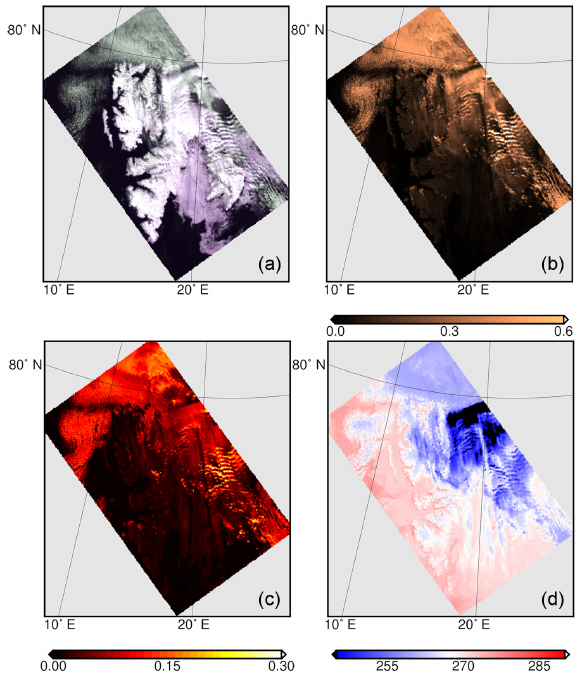
Figure 1. (a) The false-colour RGB image of AATSR (using 0.67, 0.87 and 0.55µm channels) over Svalbard, 10 May 2006, (b) 1.6µm reflectance, (c) 3.7µm reflectance, (d) 11µm brightness tempera-